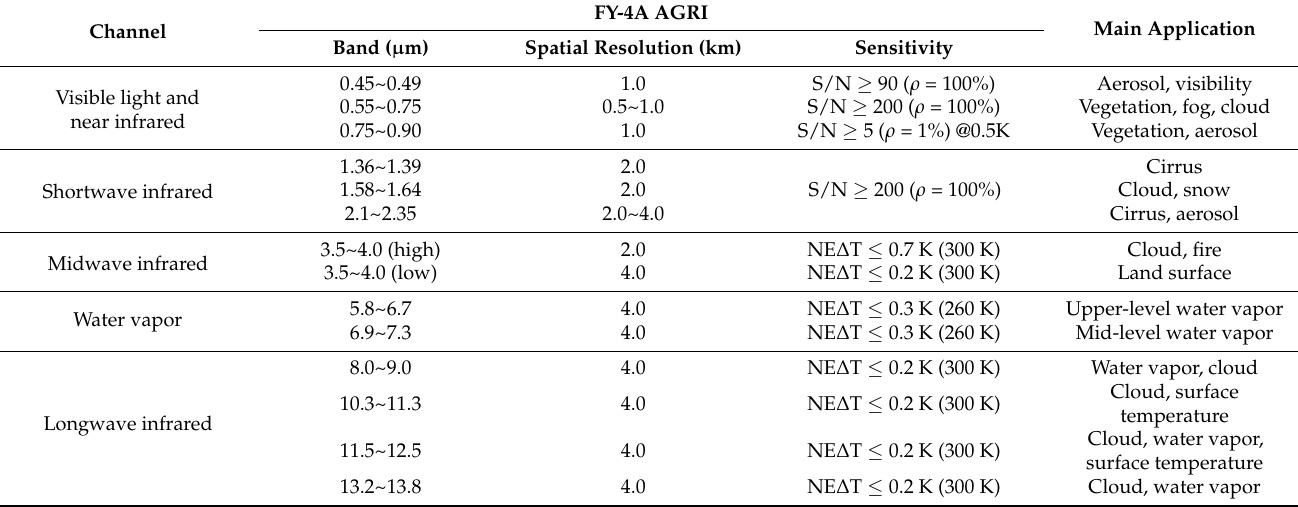
Table 1. FY-4A AGRI